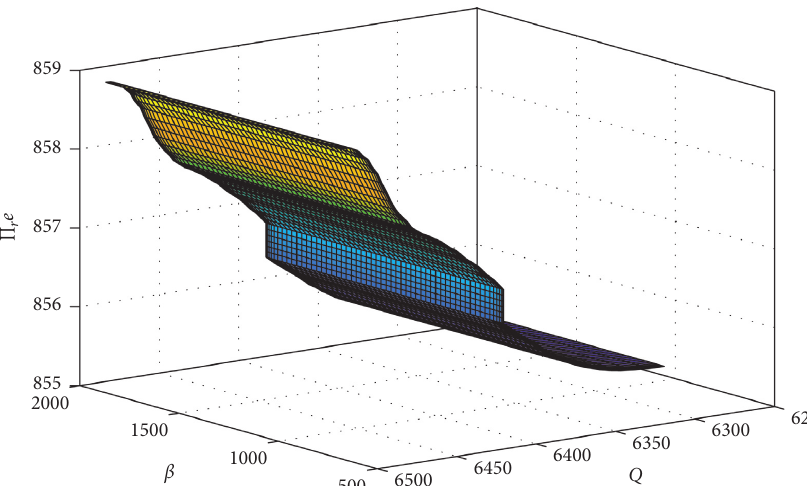
Figure 6: The impact of carbon emission reduction cost factors and order quantities on the revenue of recyclers under centralized decision- making.